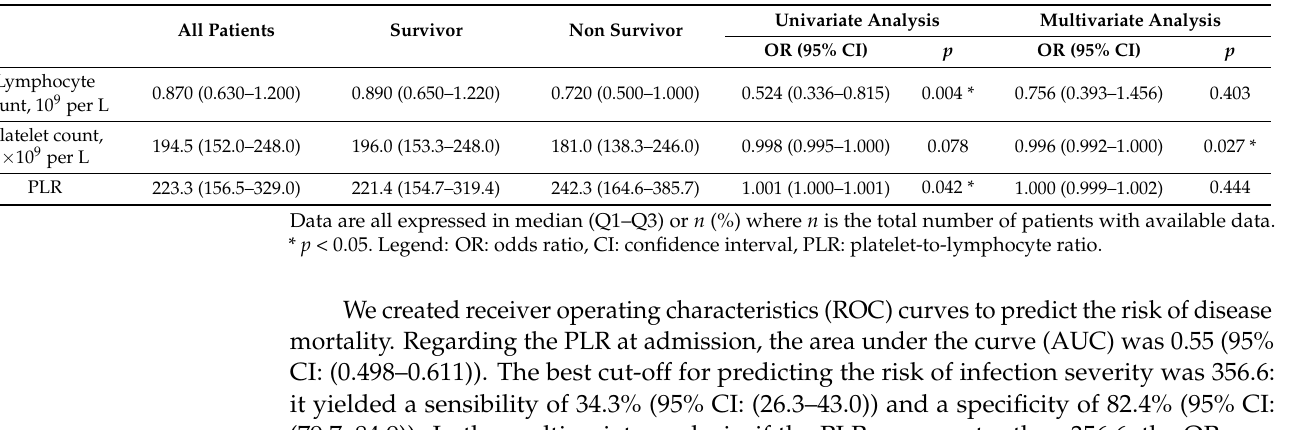
Figure 2. Receiver operating characteristics (ROC) curve for PLR as a predictive factor of severe COVID-19. Table 4. Univariate and multivariate analyses for risk factors for COVID-19